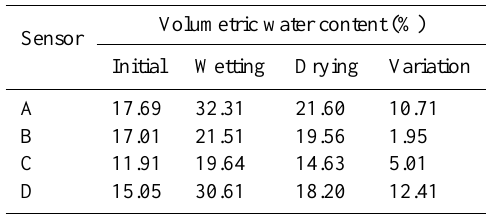
Table 3. Variation of volumetric water content in the model slope of 50 ◦ inclination.